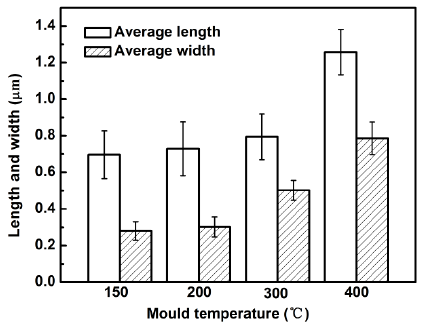
Figure 6. Variations of the length and width of eutectic Si phases with mold temperature.